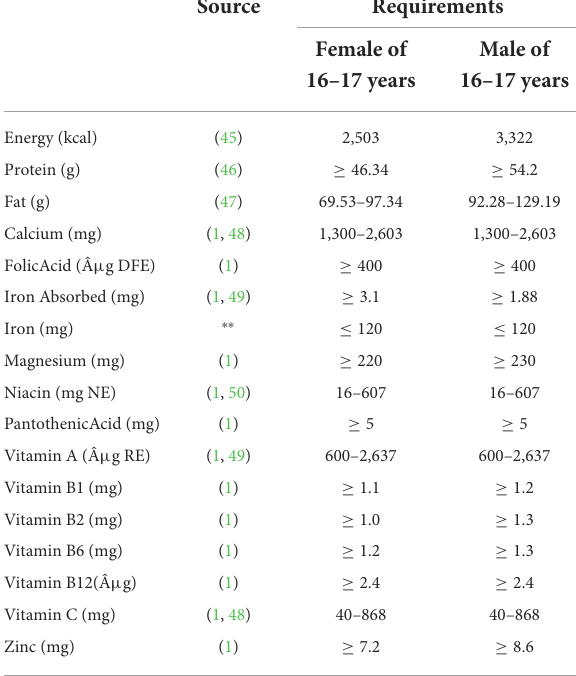
TABLE 1 Daily nutritional requirements of an adolescent male and